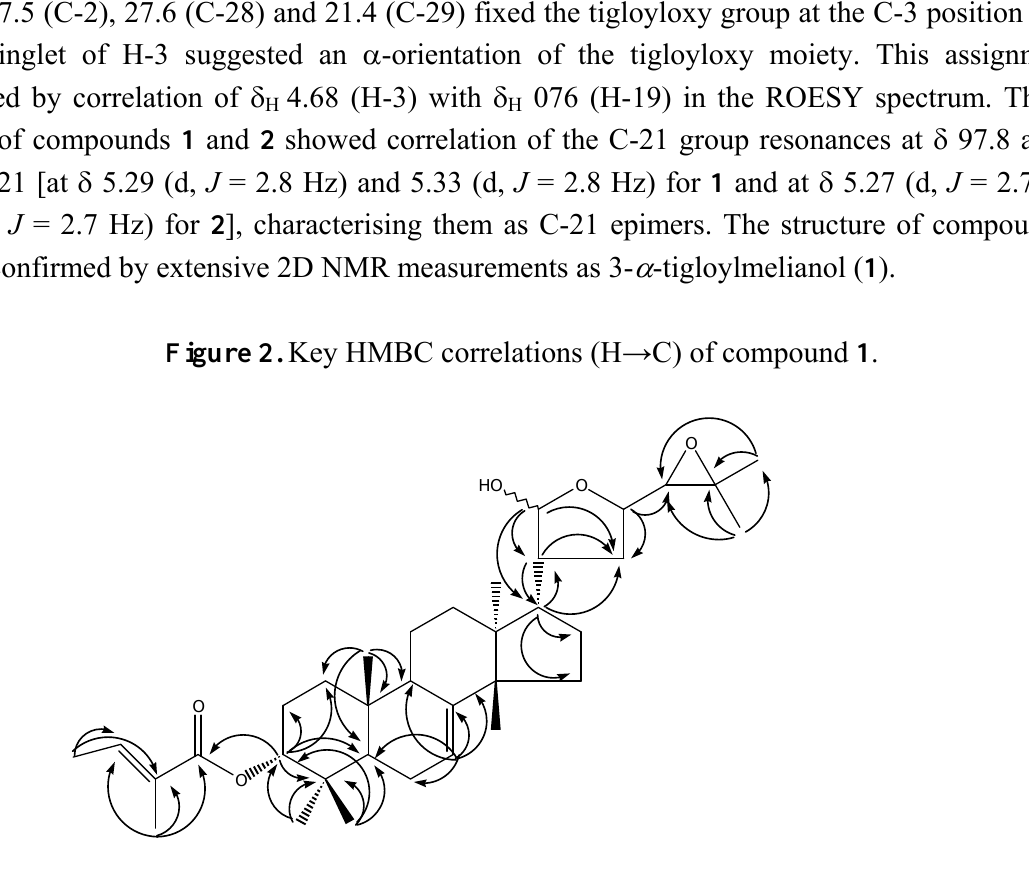
, δ in ppm and J in Hz). 3